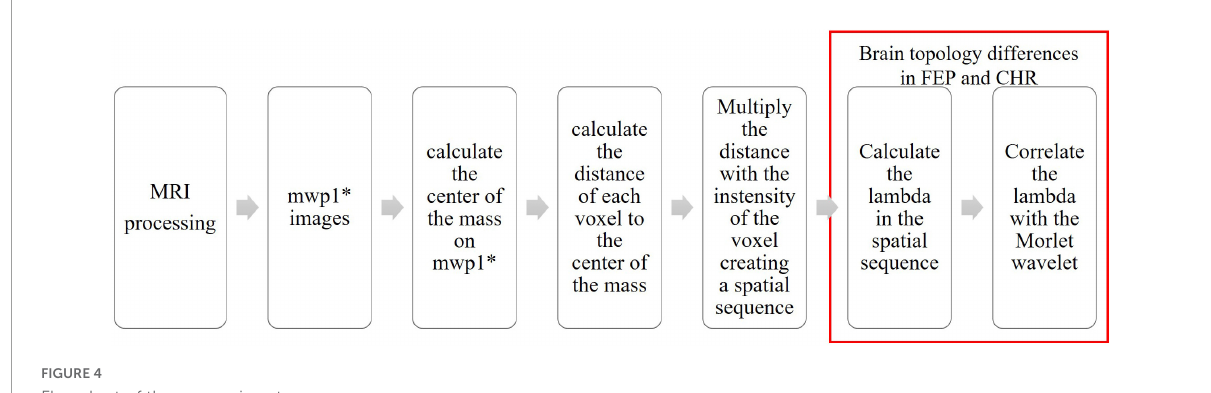
FIGURE4 Flowchart of the processing steps.